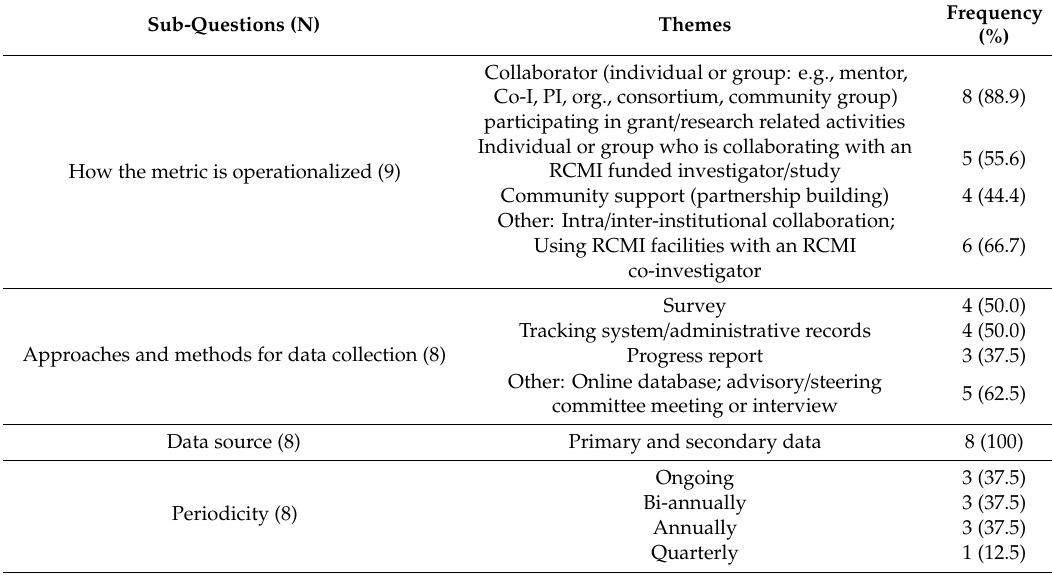
Table 4. Primary Target: Increase scientific collaborations. Key findings of the case study regarding the operationalization and data collection strategies for the metric “number of research